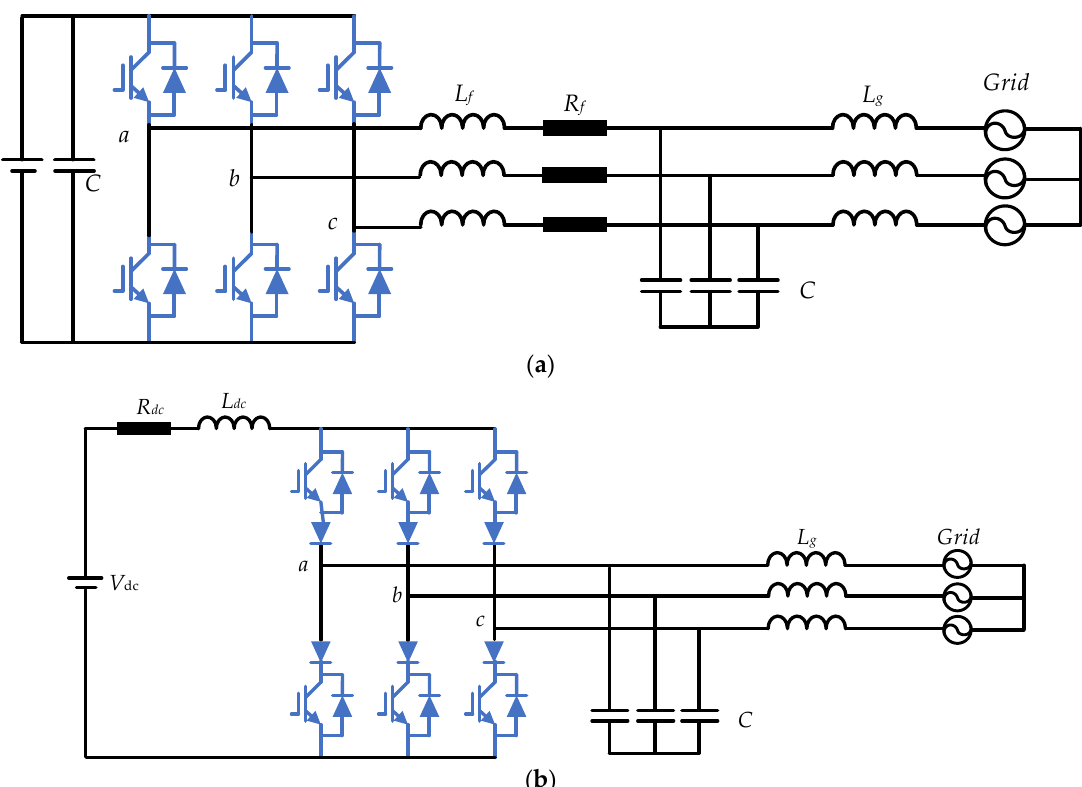
Figure 6. ( a ) Typical topology of three-phase VSI; ( b ) Typical topology of three-phase CSI.